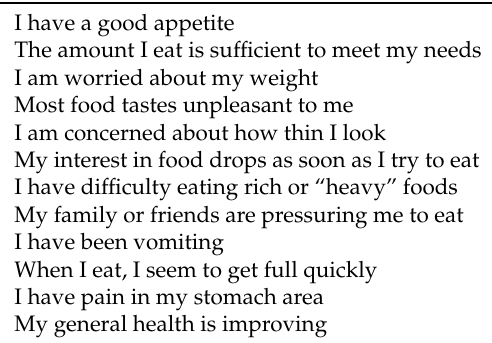
Table 2. The 12 items of the FAACT A/CS